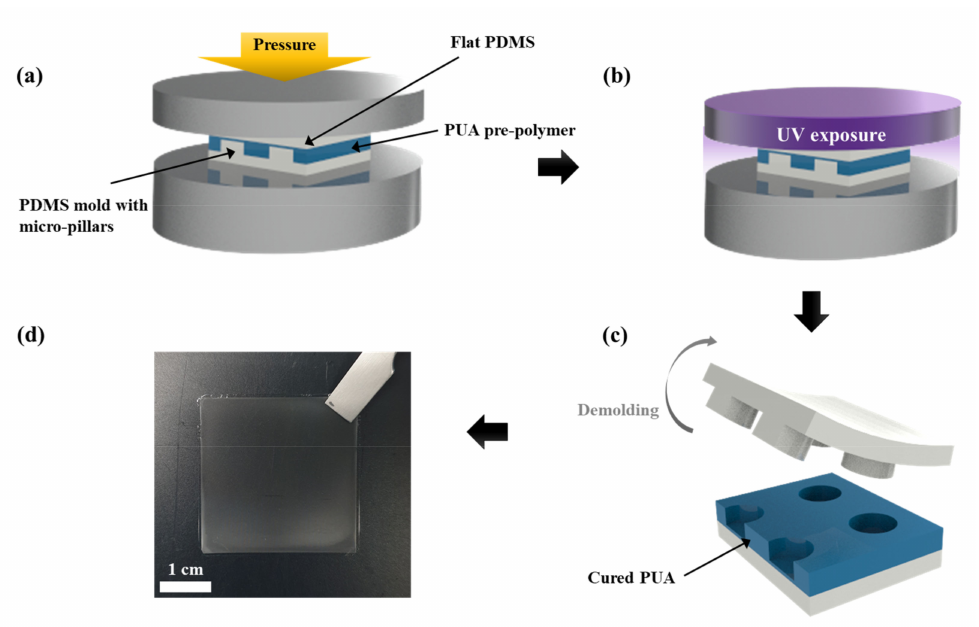
Figure 1. Schematic of the fabrication process of polymeric stencils with microdot apertures using UV imprint equipment. ( a ) Applying external pressure to the assembly of polydimethylsiloxane (PDMS) pillar patterned mold-polyurethane acrylate (PUA) prepolymer-PDMS flat mold, ( b ) ultraviolet (UV) irradiation process, ( c ) peeling off the PDMS molds, ( d ) Digital camera image of the free-standing PUA stencil with microdot